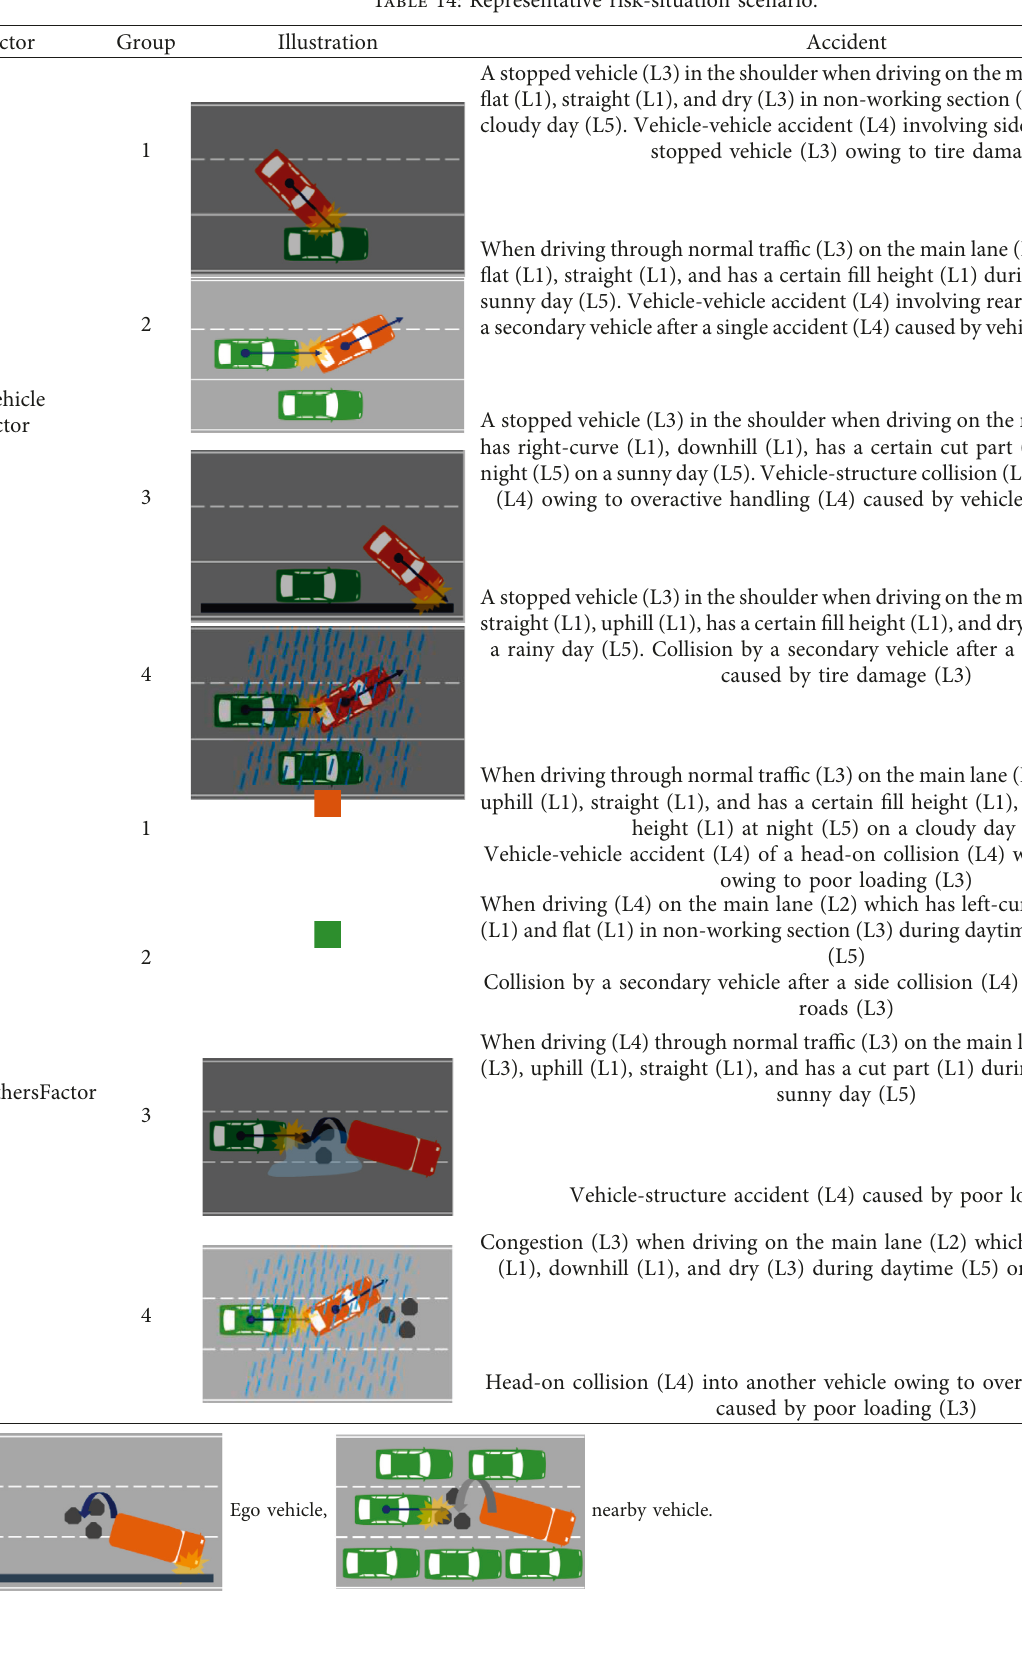
Table 14: Representative risk-situation